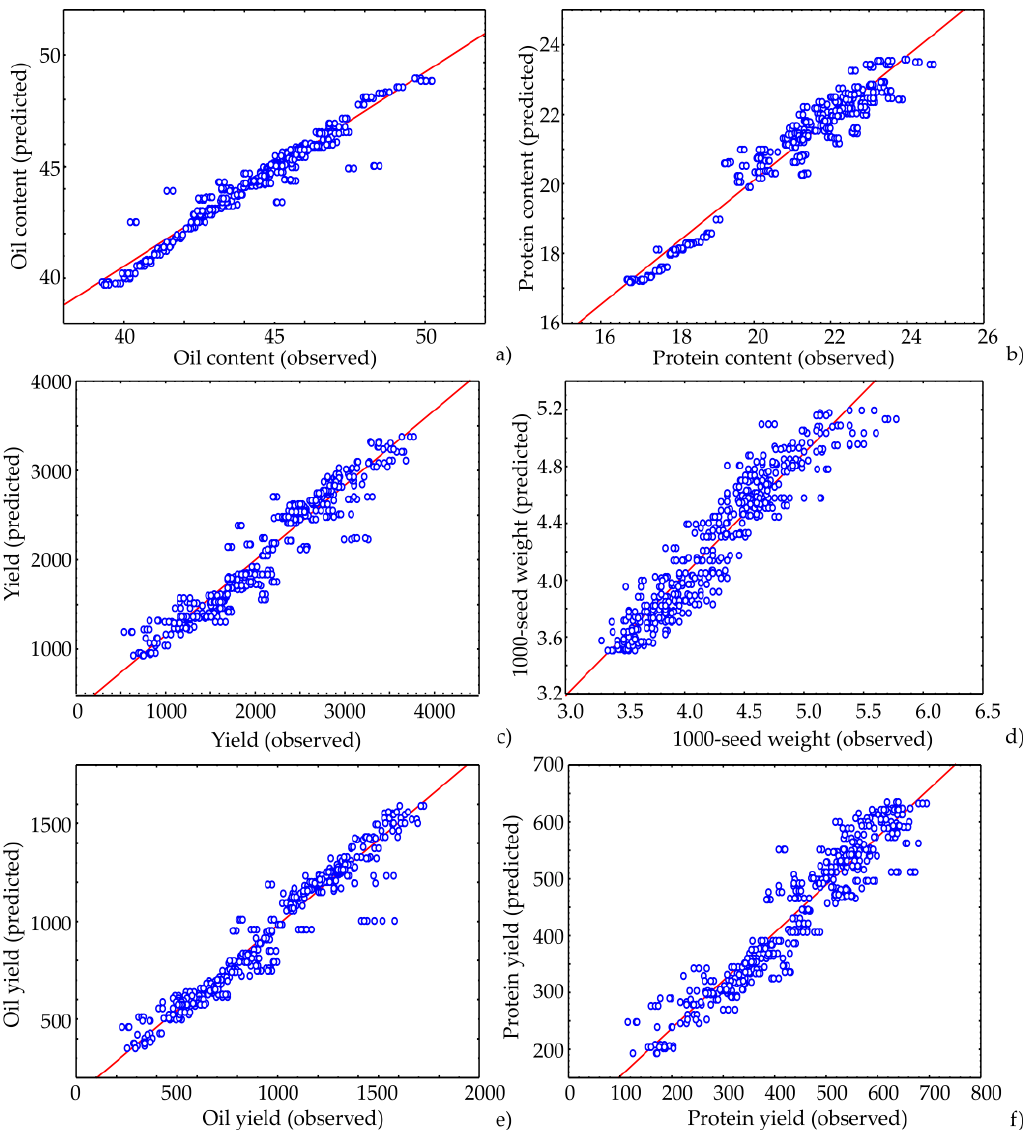
Figure 3. Comparison between experimentally obtained and RFR model predicted values of ( a ) oil and ( b ) protein content, ( c ) yield, ( d ) 1000 seed weight, ( e ) oil yield, and ( f ) protein yield. Table 4. The goodness of fit tests for the developed ANN